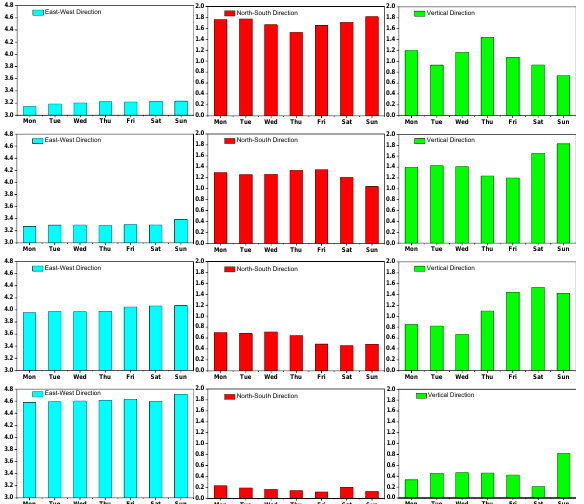
Figure 8. Daily vibration acceleration in a week(mm/s2) Through analysis of daily mean variation in a week of four selected weeks, it found that the variation trends of three- dimensional vibration acceleration from Monday to Sunday in each week of different months were not the same. The vibration acceleration in east - west direction was on a rise basically and reached its maximum on Sunday; the change law in north - south direction was always different from that in vertical direction, but the change law was not clear; the vibration acceleration in east - west direction was significantly greater than that in north - south direction and vertical direction.